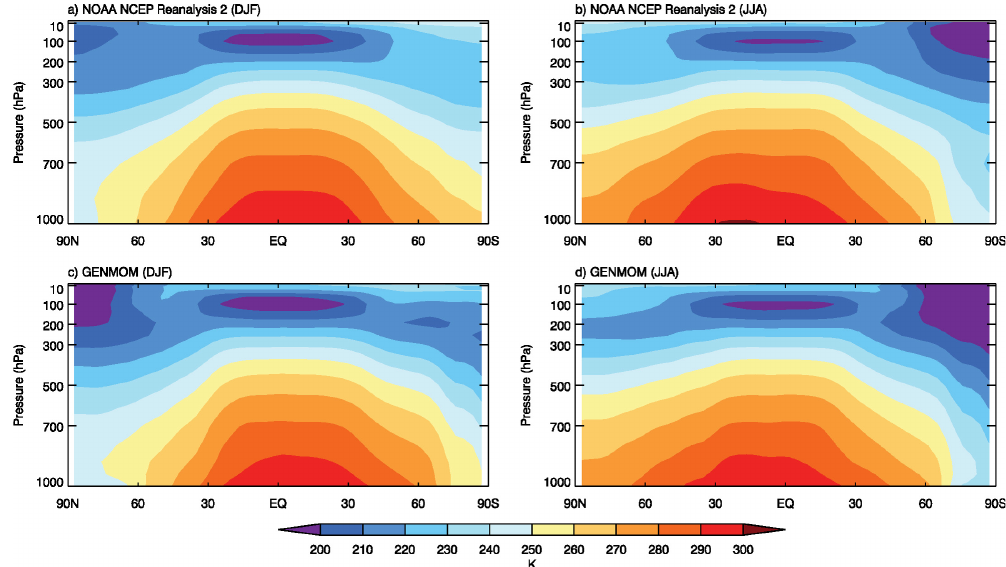
Fig. 1. Mean-annual zonal averaged atmospheric temperature profiles. (a) Observed (NCEP2, 1981–2005) December, January, February (DJF), (b) Observed June, July, and August (JJA), (c) GENMOM DJF, (d) GENMOM JJA.